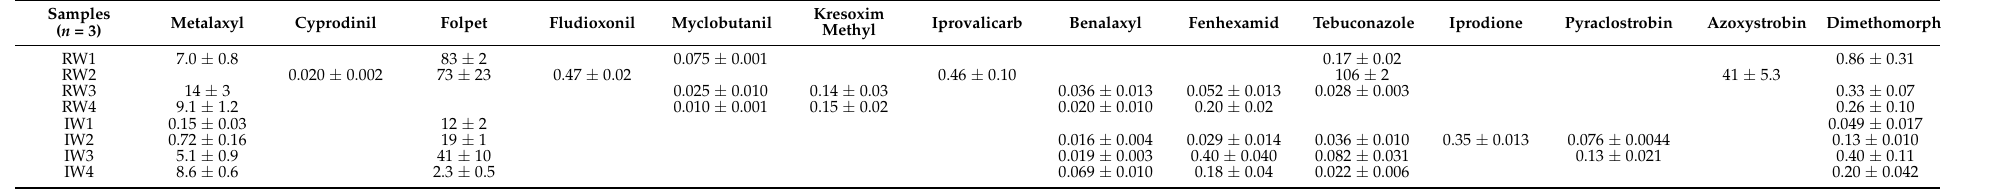
Table 6. Concentration ± SD ( µ g L − 1 ) of detected fungicides in rainwater (RW) and irrigation water